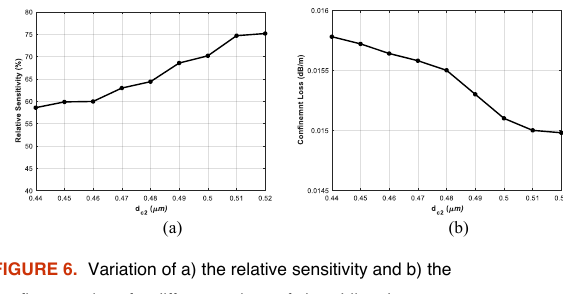
FIGURE 6. Variation of a) the relative sensitivity and b) the confinement loss for different values of d c2 , while other parameters are kept